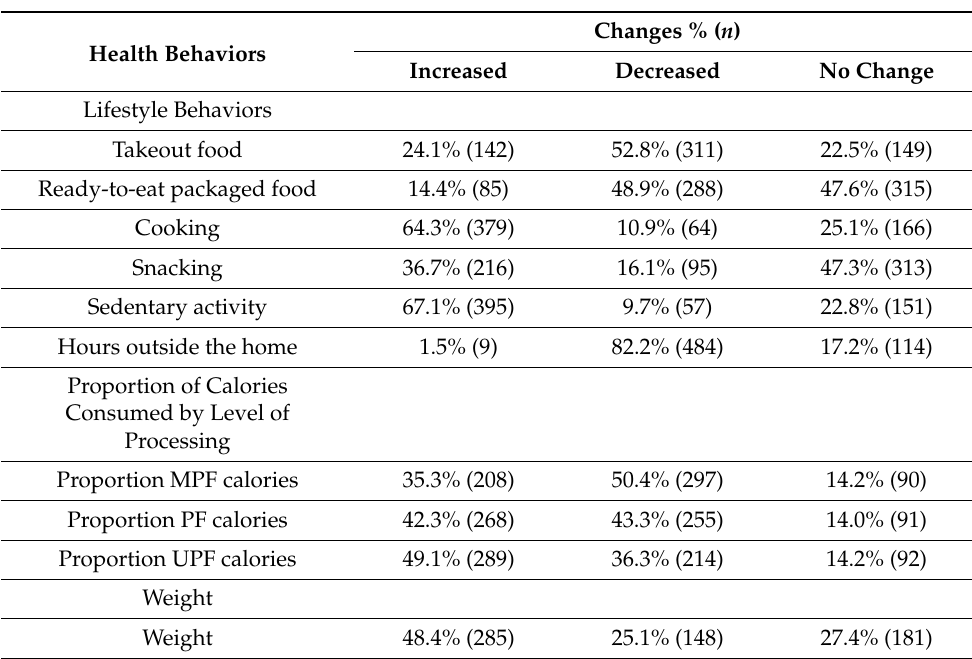
Table 2. Changes in lifestyle behaviors, diet, and